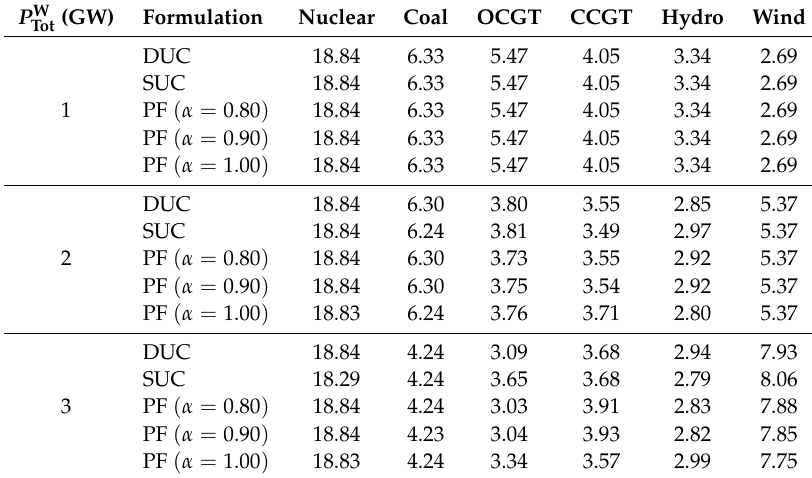
Table 5. Day-ahead energy scheduling (GWh).